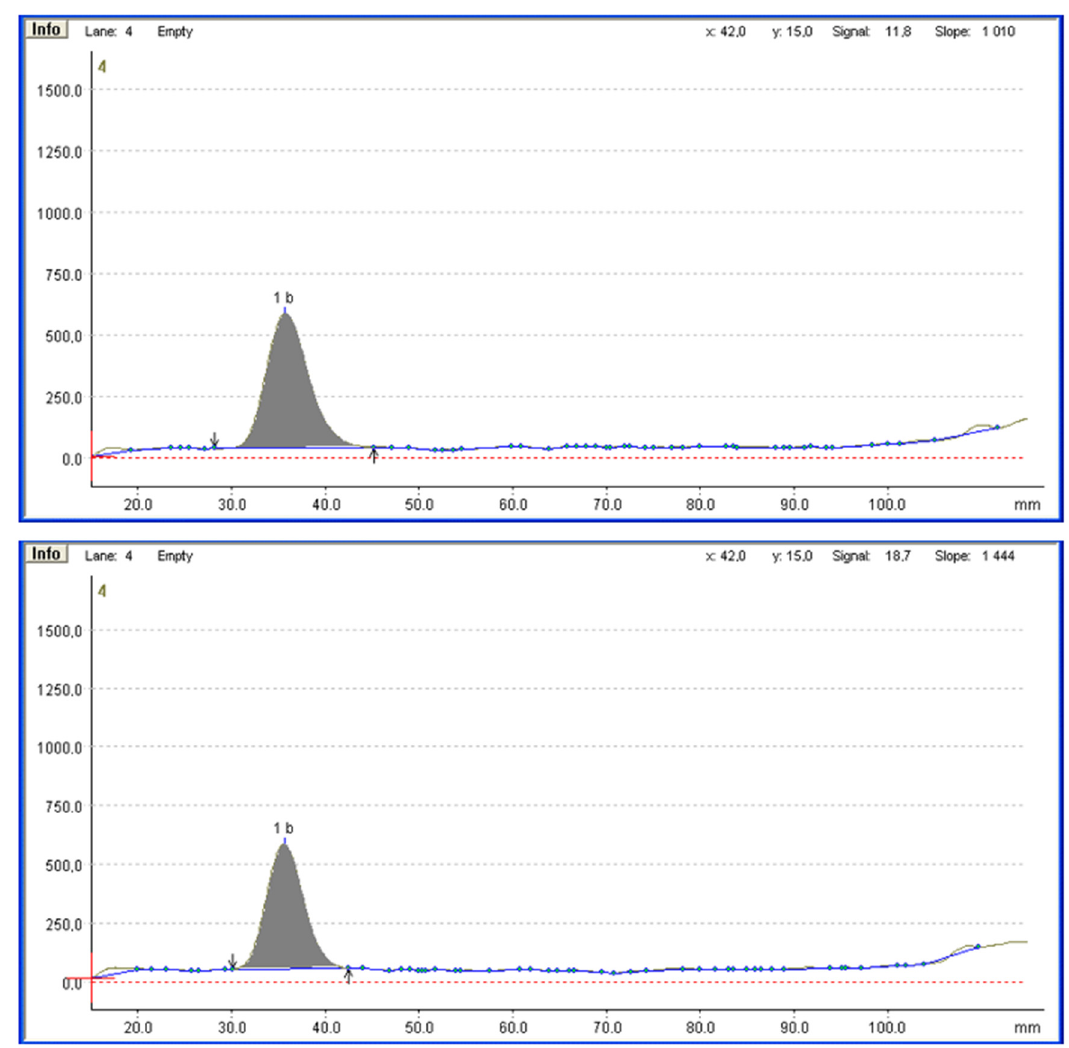
Figure A5. Example TLC chromatogram, results obtained from control (upper picture) and BSA-impregnated NP plate (lower picture). In this case, doxepin is presented. The measurement was performed using λ = 240 nm. The R f were 0.34 for the control and 0.31 for the impregnated plate.